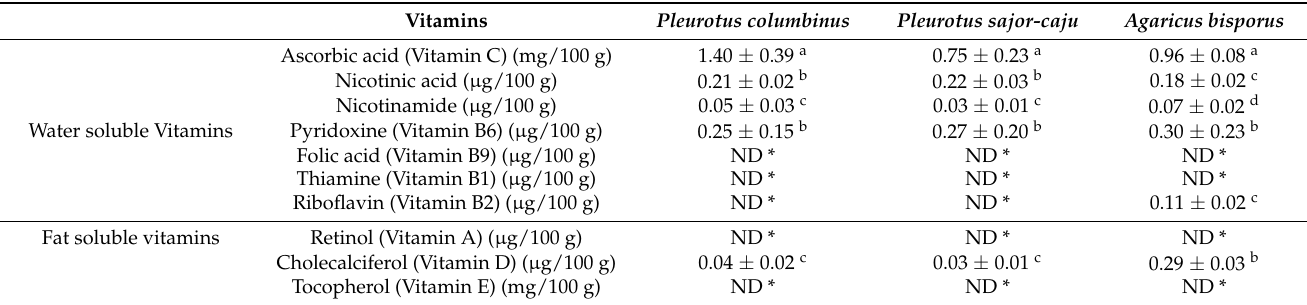
Table 3. Total vitamin content of the test mushroom species.